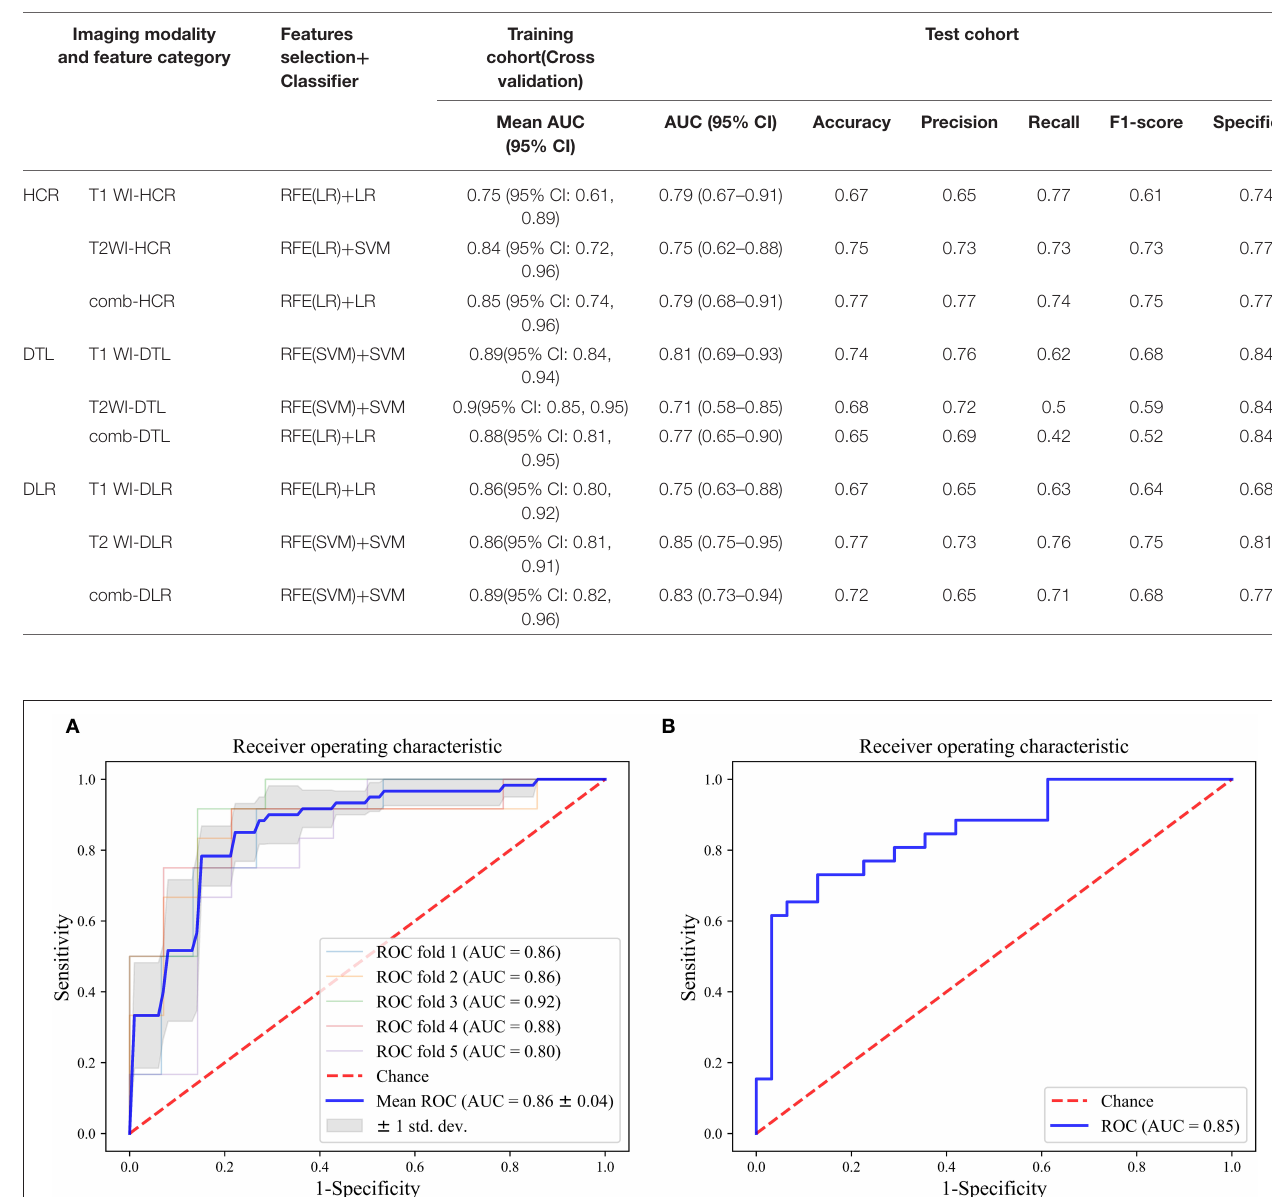
TABLE 1 | Model representation.